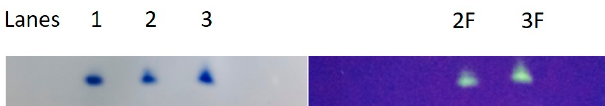
Figure 2. Acidic gel electrophoresis of dendrimers. Lane 1 represents unlabeled G4-90/10; Lane 2 represents G490/10 reacted with 50% mol fluorescein isothiocyanate (FITC) added compared to the mol of amine groups in the dendrimer ( 2F ); Lane 3 represents G4-90/10 reacted with 100% mol FITC added compared to the mol of amine groups in the dendrimer ( 3F ). Since there was not much difference in the intensity between the two, we decided to use the dendrimer prepared shown in lane 2 to avoid decreasing the conjugate’s aqueous solubility by adding more FITC.